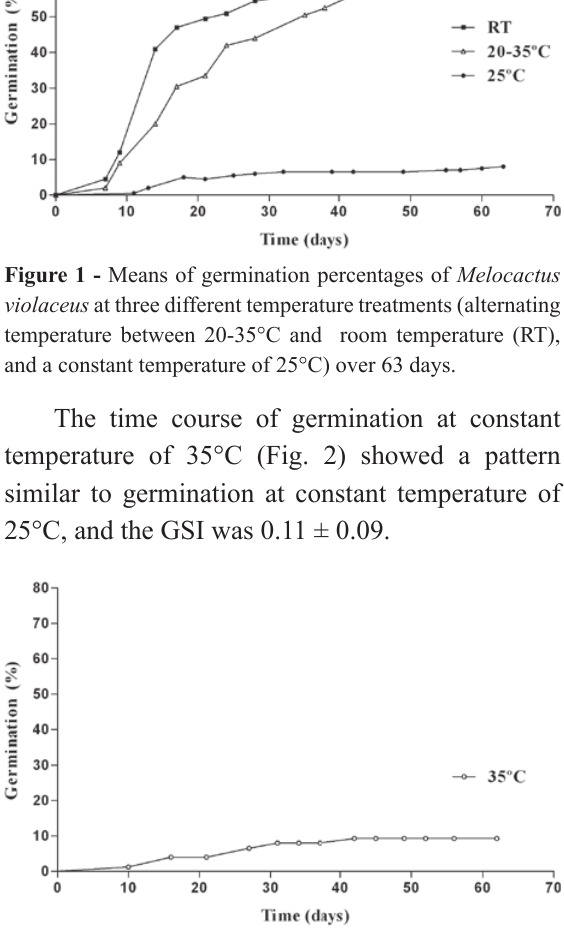
Figure 2 - Means of germination percentages of Melocactus violaceus at constant temperature of 35°C over 63 days.